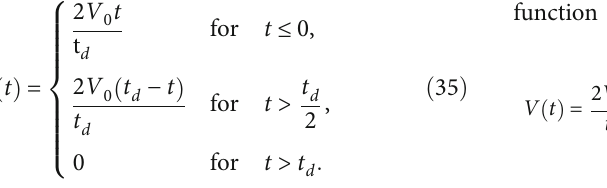
Figure 16: Central displacement of a simply supported beam subjected to rectangular piezoelectric impulse voltage for t d = / L = ð 0 : 6,0 : 9 Þ . 1 : 5 T , x a